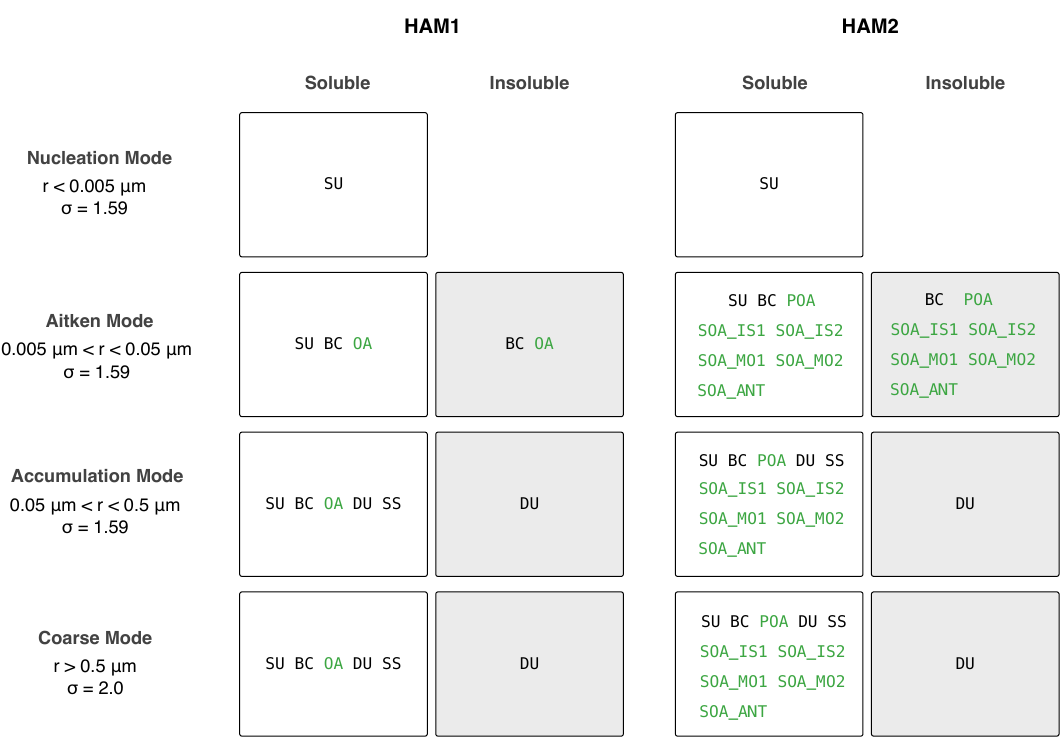
Fig. 1. Aerosol modes and compositions considered in HAM1 and HAM2. The chemical compositions include sulfate (SU), black carbon (BC), primary organic aerosol (POA), mineral dust (DU), sea salt (SS), and secondary organic aerosol (SOA). SOA can be further divided into different products from isoprene oxidation (SOA IS1 and SOA IS2), from monoterpene oxidation (SOA MO1 and SOA MO2), and from the oxidation of anthropogenic precursors (SOA ANT). In HAM1, SOA and POA are assumed to have the same properties, thus are denoted collectively by OA in the diagram. The text in green highlights differences between the two model versions. As for the mode parameters, r stands for the number median radius, and σ the prescribed standard deviation. Modified from Table 1 in Stier et al.